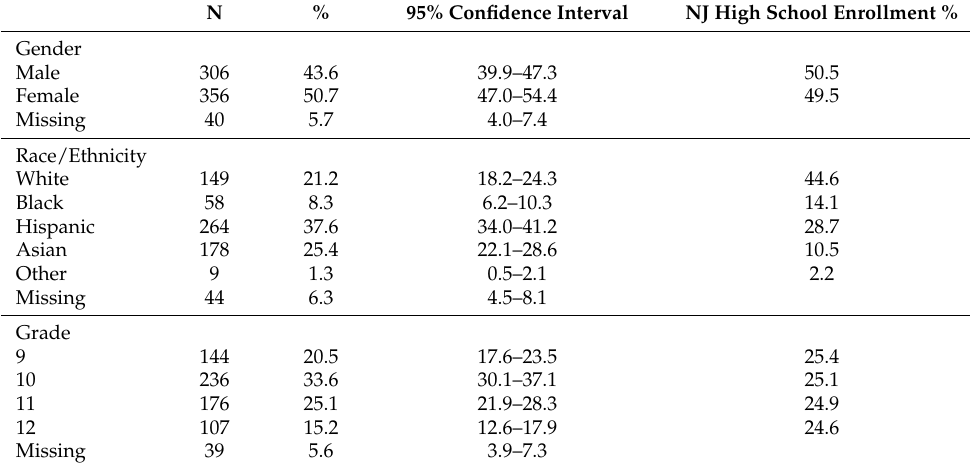
Table 1. Sample demographics, NJYTS 2021 (n =